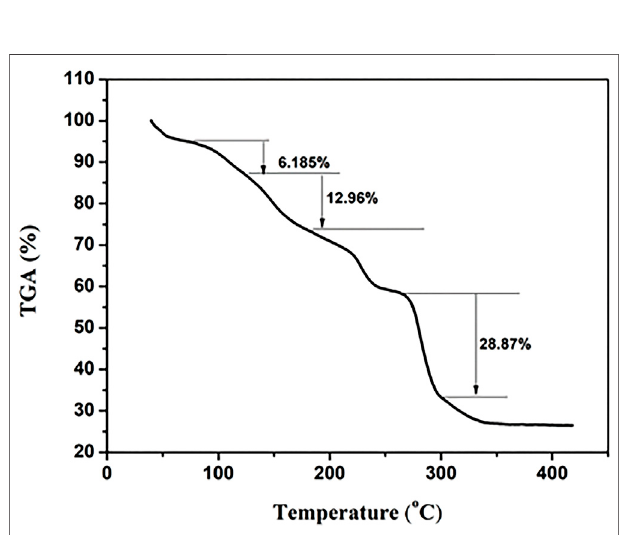
FIGURE 4 | Survey-scan XPS spectrum of LCP-1 (A) and high-resolution spectra of C1s (B) , N1s (C) , and O1s (D) .